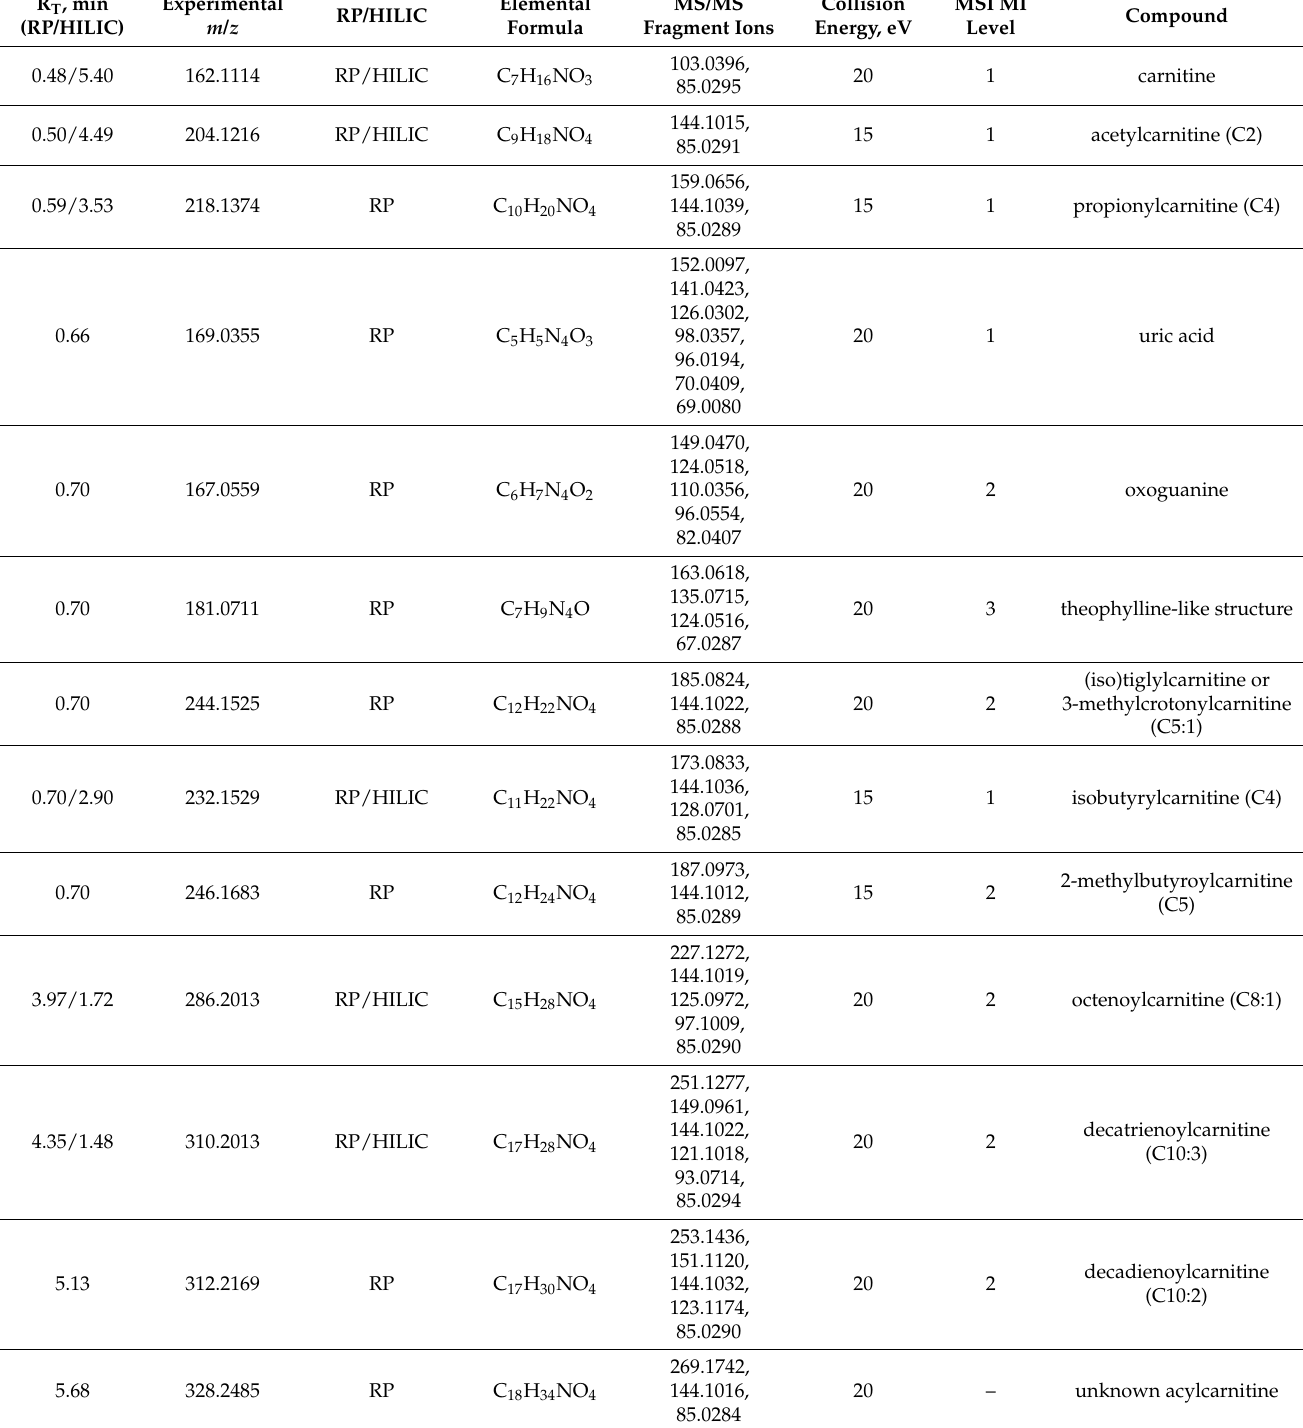
Table 1. Mass spectrometry (MS) characteristics of diet-associated discriminant features detected by reverse-phase (RP) chromatography and hydrophilic interaction chromatography